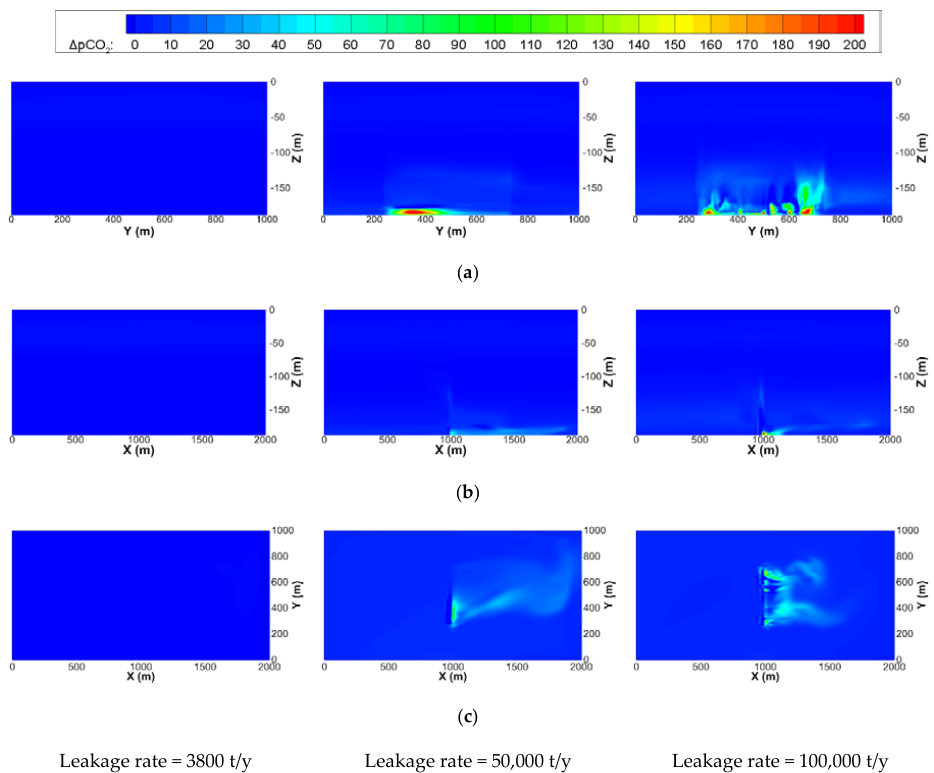
8 Figure 8. Contour maps of ∆ pCO 2 on the center planes of the x, y, and z directions of the small-scale domain at 30 days after the start of leakage with the same initial diameter of bubble of 20 mm and leakage area of 20,000 m 2 but with di ff erent leakage rates. ( a ) Center plane in x direction (x = 1000 m);